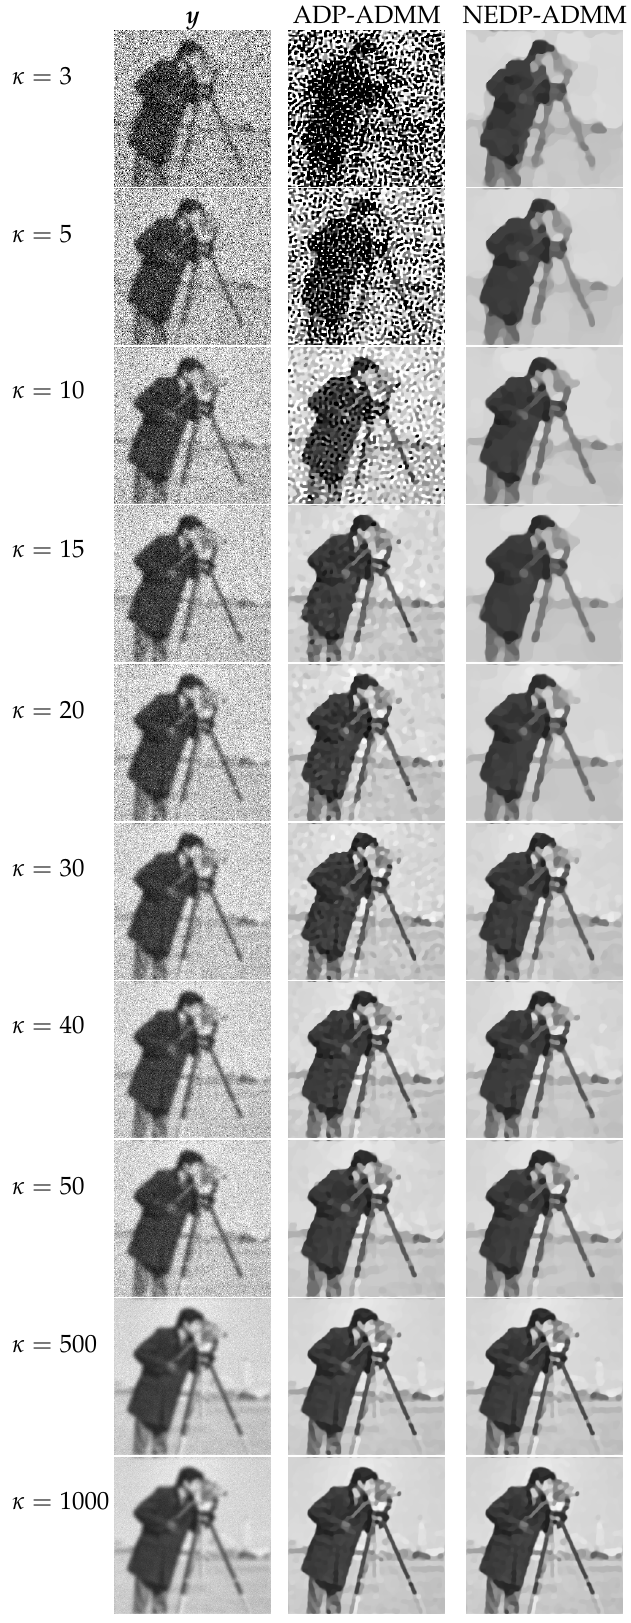
Figure 8. Test image cameraman . Left column: observed data y corrupted by Gaussian blur with parameters band = 13, sigma = 3 and Poisson noise with different κ -values ranging from 3 to 1000. Middle column: restorations by ADP-ADMM. Right column: restorations by